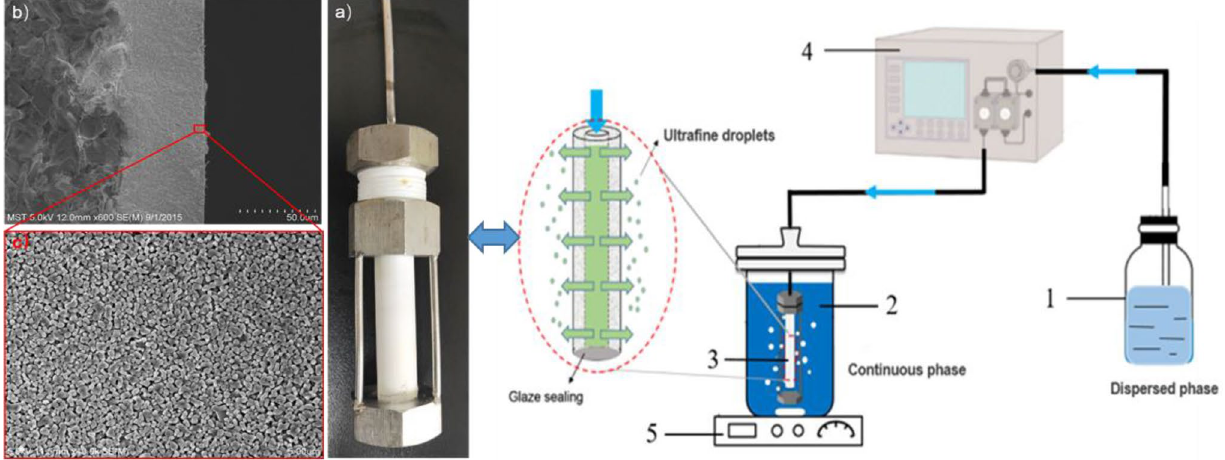
Fig. 1 Left: a the photograph of ceramic membrane module, b side-view SEM image and c surface SEM image of ceramic membrane; Right: The ceramic membrane reactor: (1) dispersing phase, (2) continuous phase, (3) ceramic membrane module, (4) pump and (5)